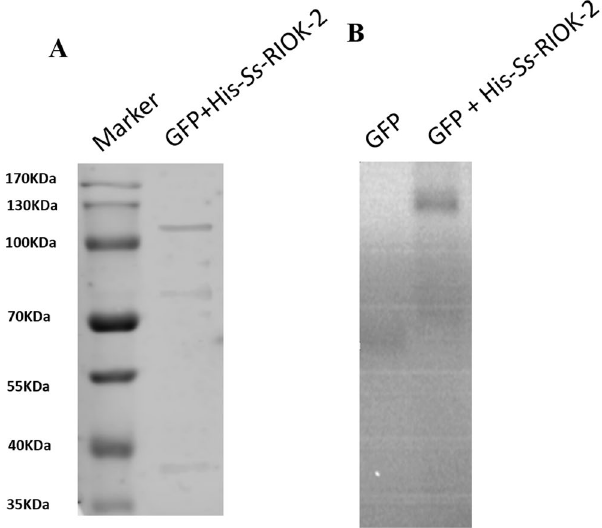
Figure 8. Autophosphorylation of recombinant His- Ss- RIOK-2. ( A ) Western-blot of His- Ss- RIOK-2 immunoprecipitated with His antibody. ( B ) Kinase assay showing autophosphorylation activities of recombinant His- Ss-